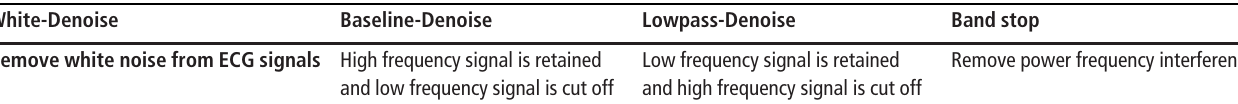
Table IV The de fi nitions of parameters for denoising preprocess White-Denoise